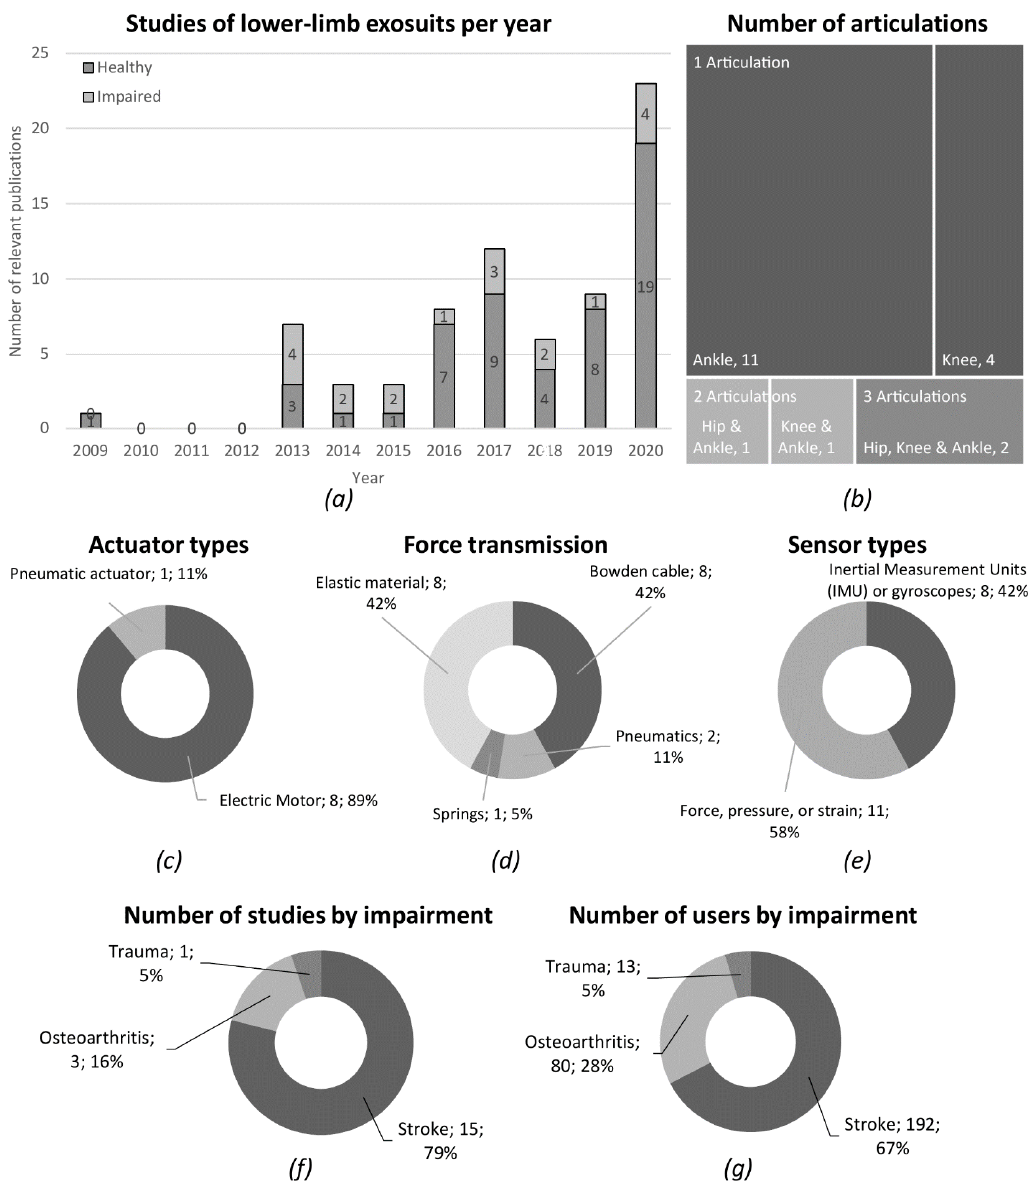
Figure 2. ( a ) Number of relevant publications per year, separated by impaired and healthy test subjects; ( b ) tree map chart of articulations addressed by the exosuits by number of publications; ( c ) actuator types used for force generation by number of publications; ( d ) techniques of force translation employed by number of publications; ( e ) sensor types used for measurement in the exosuits; ( f ) percentage of studies by impairment; and ( g ) percentage of users enrolled by different impairments.